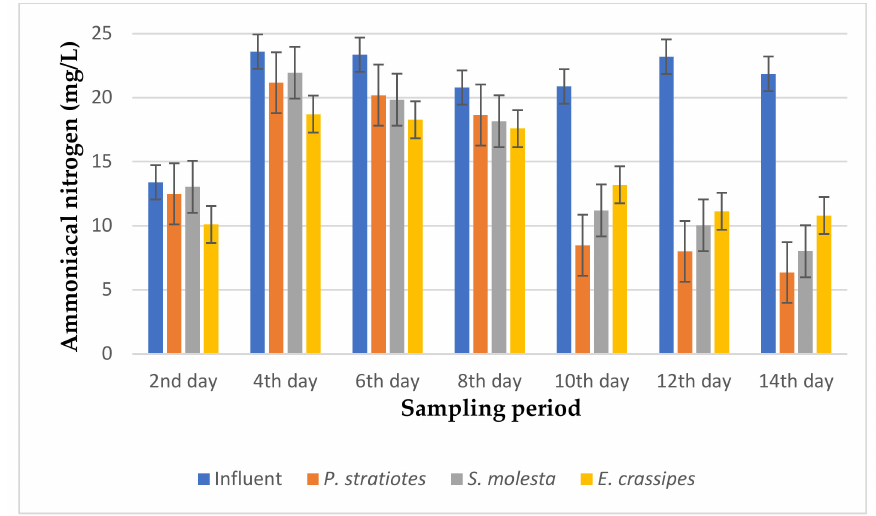
Figure 10. Bar plot of the average ammoniacal nitrogen vs. the sampling period with a 12 h retention time.